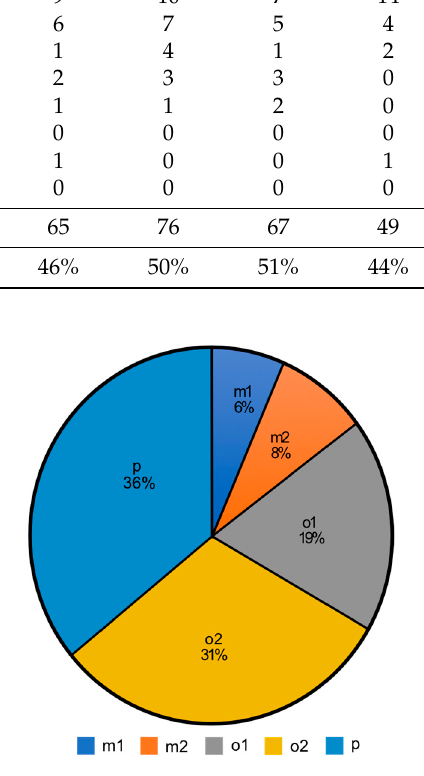
Figure 8. Share of SD species according to their larvae plant specificity. m1-1st degree monophagous, m2-2nd degree monophagous, o1-1st degree oligophagous, o2-2nd degree oligophagous (see text for details) and po-polyphagous.